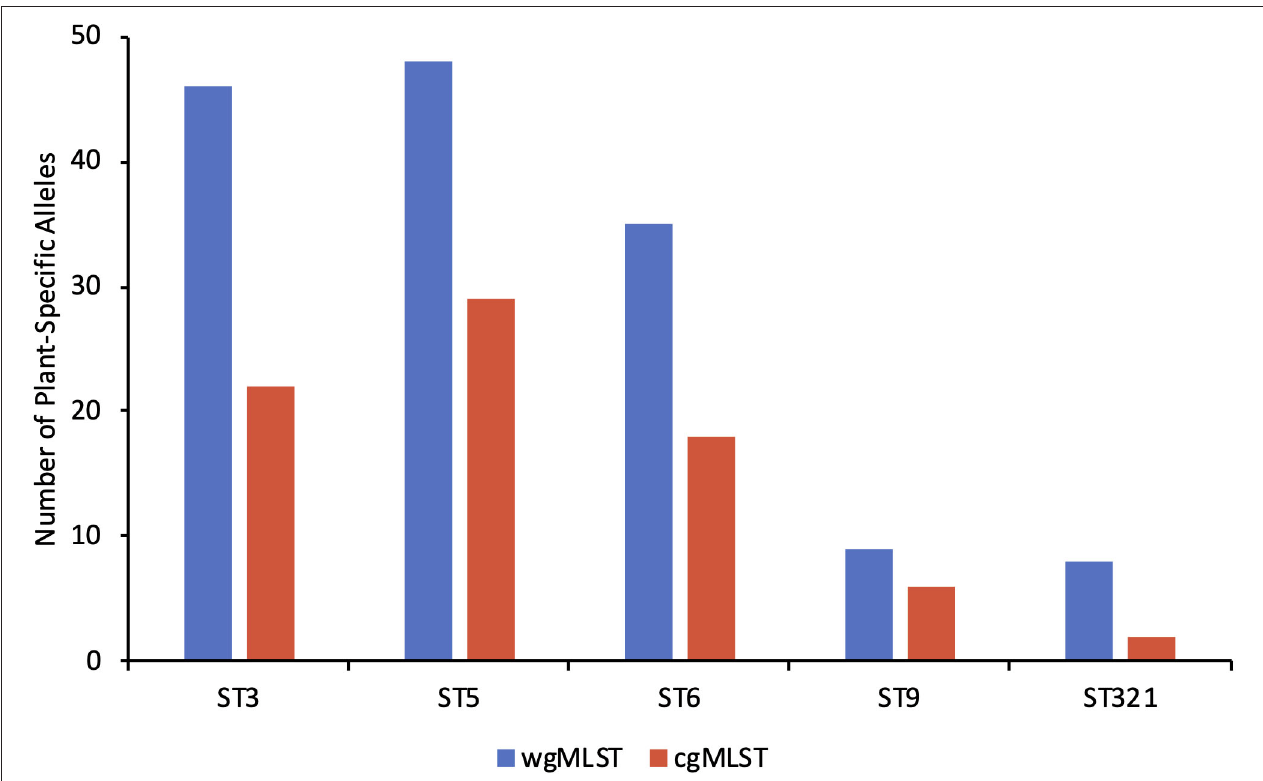
FIGURE 3 | The number of facility-specific alleles based on whole genome MLST (blue) and core genome MLST (red) in sequence types 3, 5, 6, 9, and 321. Lists of the specific plant-specific alleles can be found in Supplementary Table 4 .